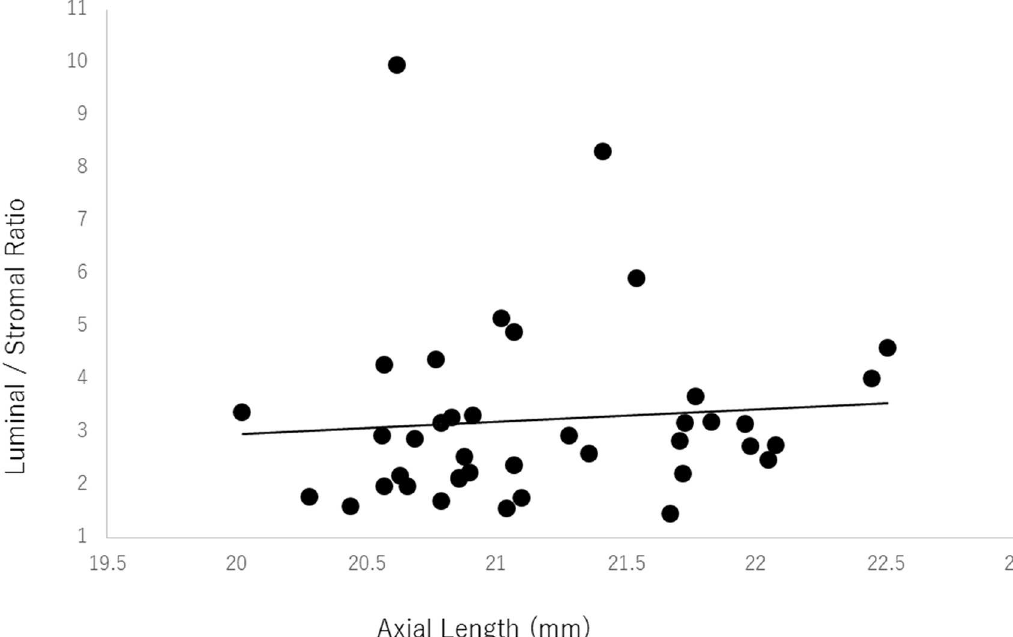
Fig 2. Relationship between the luminal/stromal ratio and the axial length of the amblyopic eyes. There was no significant correlation between the luminal/stromal ratio and the axial length ( r = 0.08, P = 0.61 Pearson’s correlation coefficient). ● : amblyopic